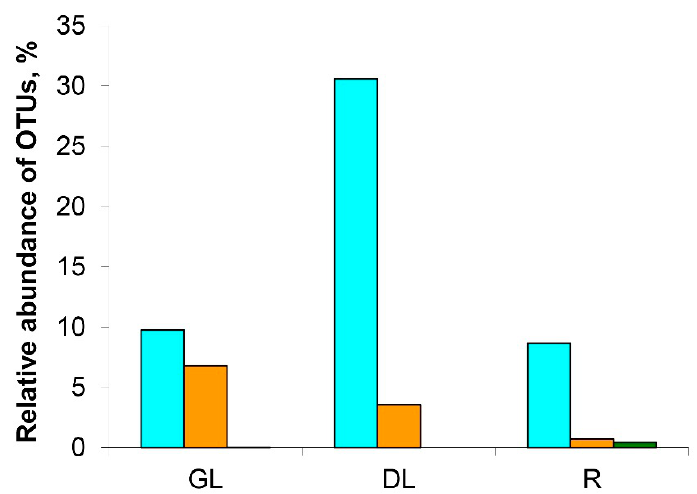
Figure 5. Relative abundance of Microdochium -related OTUs (M.OTU1—blue; M.OTU2—orange; M.OTU3—green) in the pool of fungal OTUs of snow mold-damaged winter rye. The mycobiomes of green leaves (GL), desiccated dead leaves (DL), and roots (R) were analyzed separately. All three variants together were revealed only in R-samples (8.6%, 0.7%, and 0.4% of fungal dataset for M.OTU1, M.OTU2, and M.OTU3, respectively). In the GL- and DL-samples, M.OTU3 was absent. M.OTU1 and M.OTU2 were represented rather equally in GL-samples (9.7% and 6.8%,